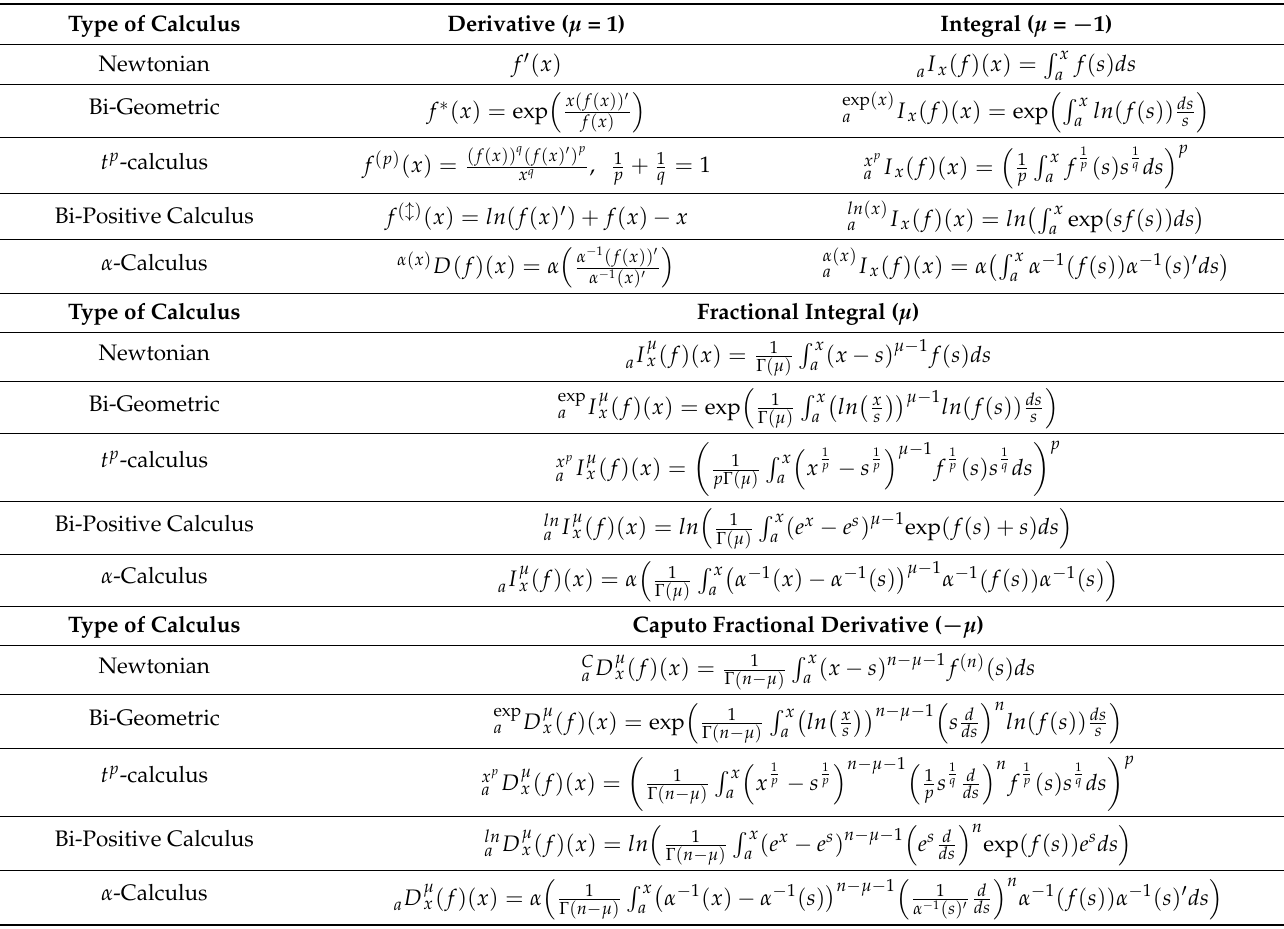
Table 1. Comparison of differentiation operators in different